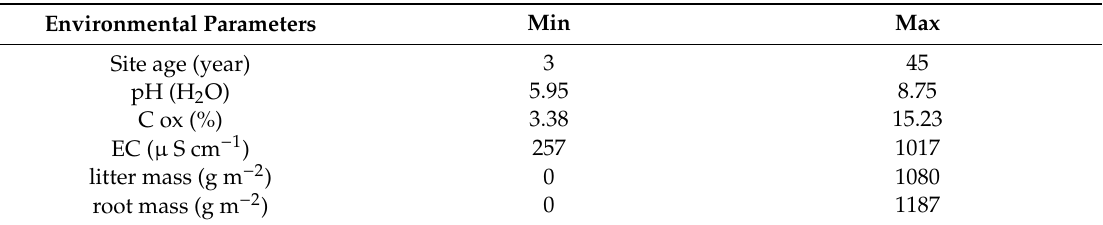
Table 1. Ranges of values for environmental parameters in the 15 sites (based on Frouz et al., 2008). Environmental